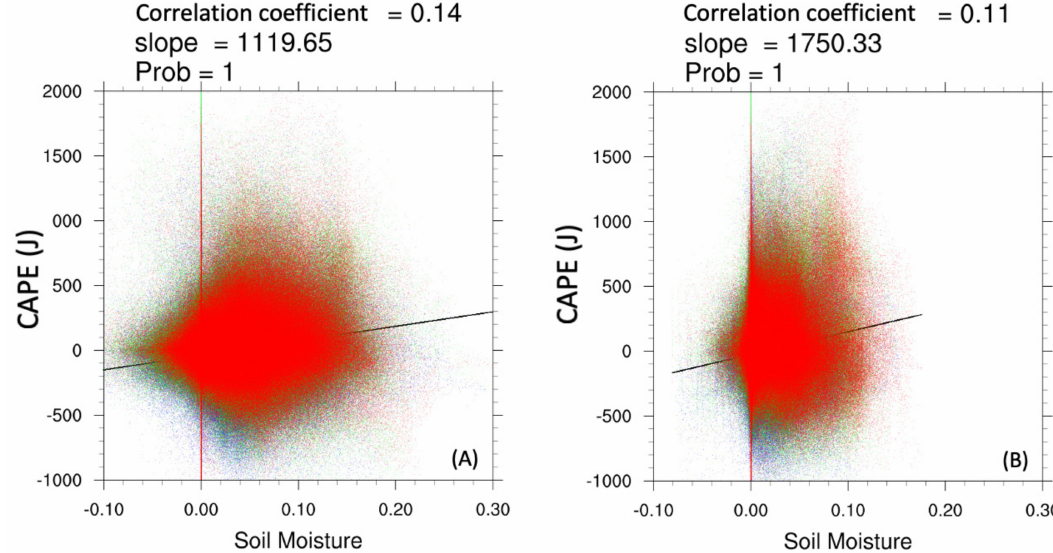
Figure 9. Volumetric soil moisture versus CAPE on 26 April 2018 (over land, only) between the hours of 0600 and 1700 UTC. The output frequency was 1 h. The CAPE values shown in the scatter plot are the differences between the Control and S-1.0 (blue), S-1.5 (green), and S-2.0 (red) simulations. ( A ) CAPE versus surface soil moisture, and ( B ) CAPE versus first layer (0.1–10 cm) soil moisture. The null hypothesis was rejected at the 5% level (“Prob” or probability = 1). A linear fit to the data showed that CAPE values in these simulations increased